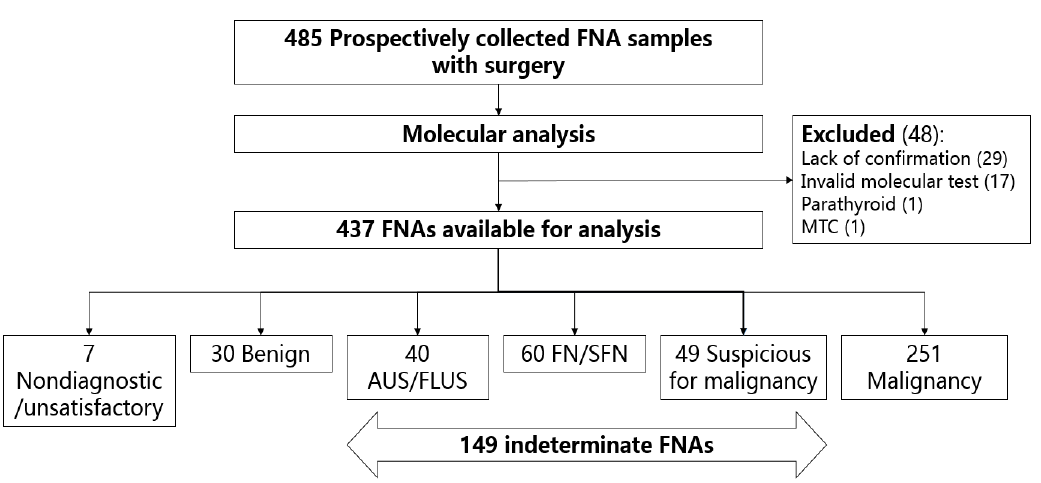
Figure 2. Schematic representation of the study design. FNA, fine-needle aspiration; MTC, medullary Figure2. Schematicrepresentationofthestudydesign. FNA,fine-needleaspiration;MTC,medullarythyroid thyroid carcinoma; AUS/FLUS, atypia of undetermined significance/follicular lesion of undetermined carcinoma; AUS / FLUS, atypia of undetermined significance / follicular lesion of undetermined significance; significance; FN/SFN, follicular neoplasm/suspicious for follicular neoplasm. FN / SFN, follicular neoplasm / suspicious for follicular